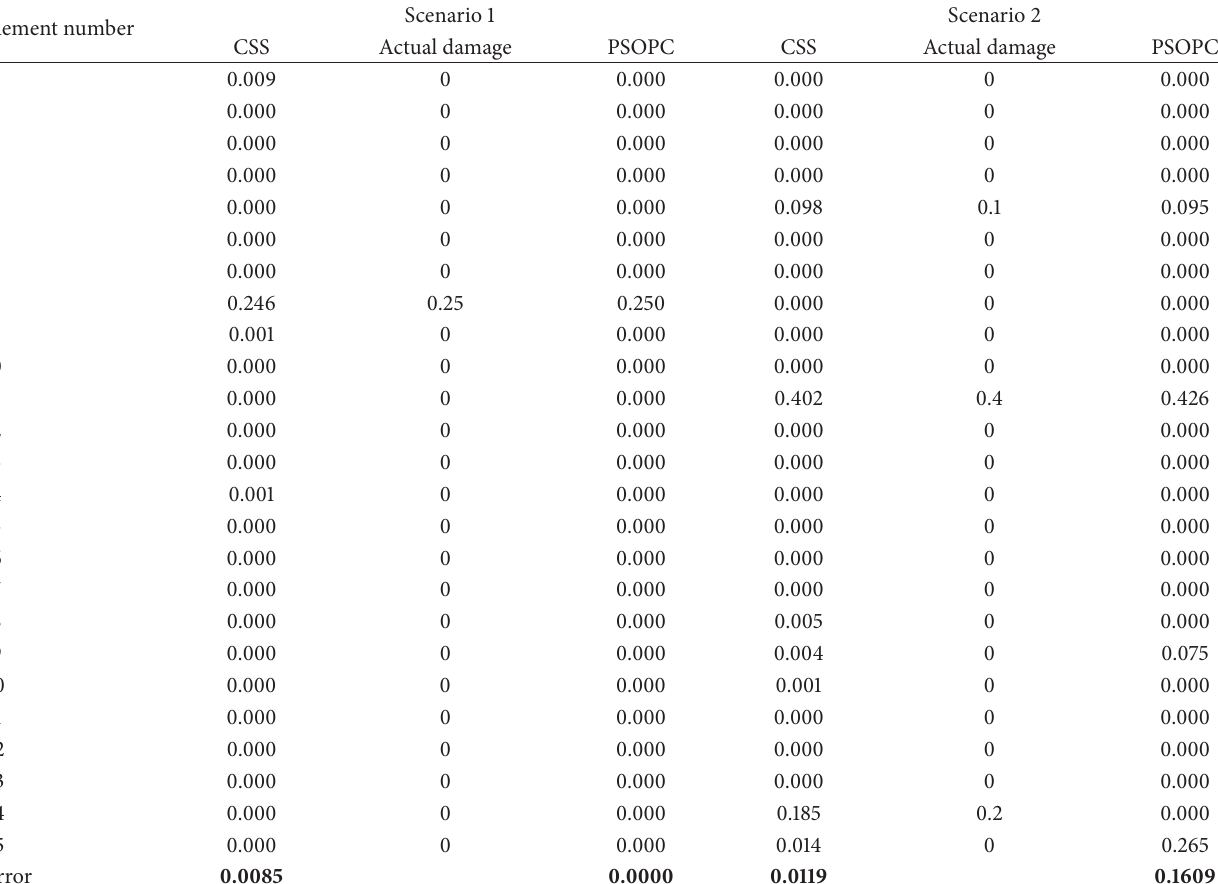
Table 6: Results of damage detection of the 25-bar Bowstring truss using CSS and PSOPC algorithms. Element